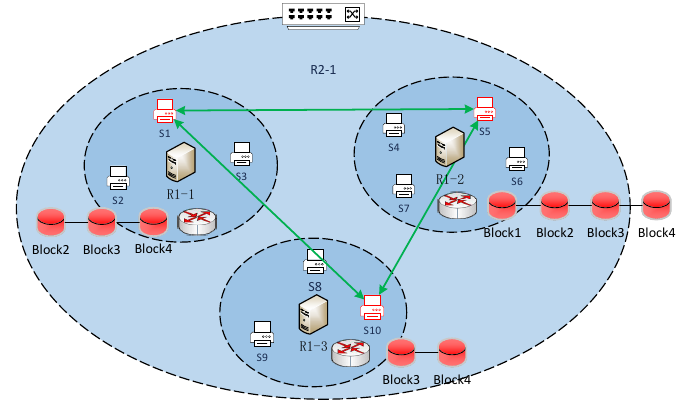
Figure 7. Collaborative block replica